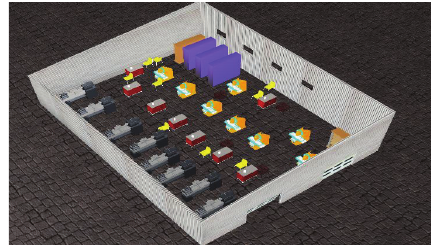
Figure 8: 3D representation of the detected obstacles and their type, red for severe obstacles, and blue for slight obstacles.